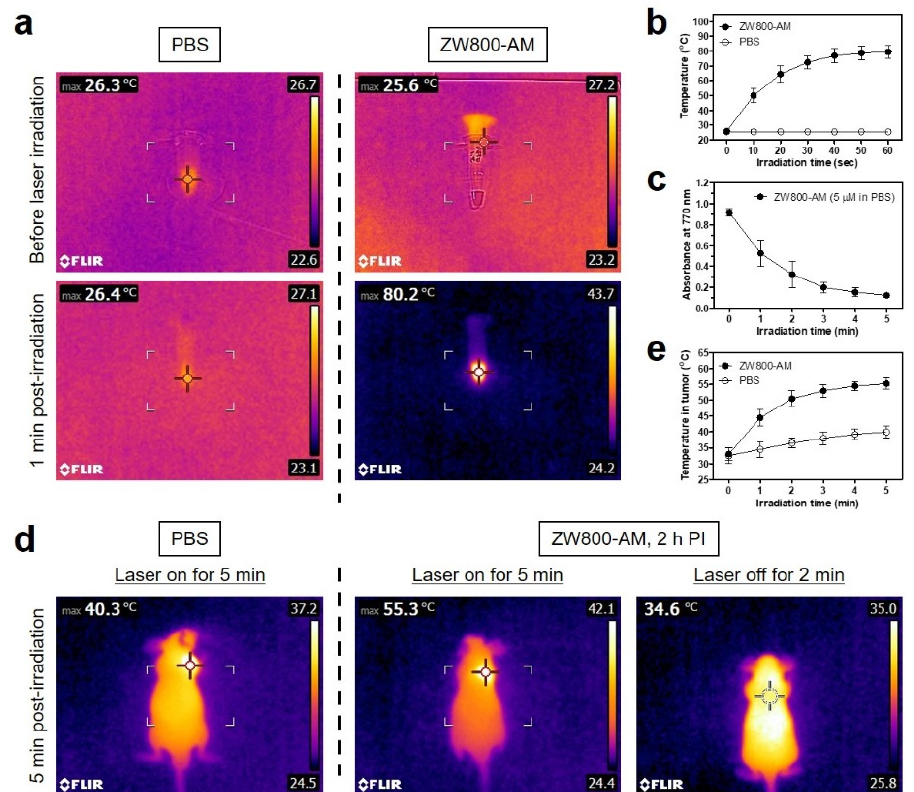
Figure 5. ( a ) In vitro thermal images of ZW800-AM solution (100 μ M dissolved in PBS) and only PBS (100 μ L) before and after 808 nm laser irradiation (1.1 W/cm 2 ) for 60 s. The maximum temperature is automatically recorded with an infrared thermal camera. ( b ) Temperature changes in each solution are observed for 60 s of laser irradiation. ( c ) Photostability of ZW800-AM during 5 min of laser irradiation. Absorbance changes are measured at 770 nm using 5 μ M ZW800-AM solutions under laser irradiation. ( d ) In vivo thermal images of tumor-bearing mice at 2 h post-injection of PBS or ZW800-AM after 808 nm laser irradiation (1.1 W/cm 2 ) for 5 min. ( e ) Temperature changes of tumors in each group are observed for 5 min of laser irradiation. Data are expressed as mean ± S.D. ( n =